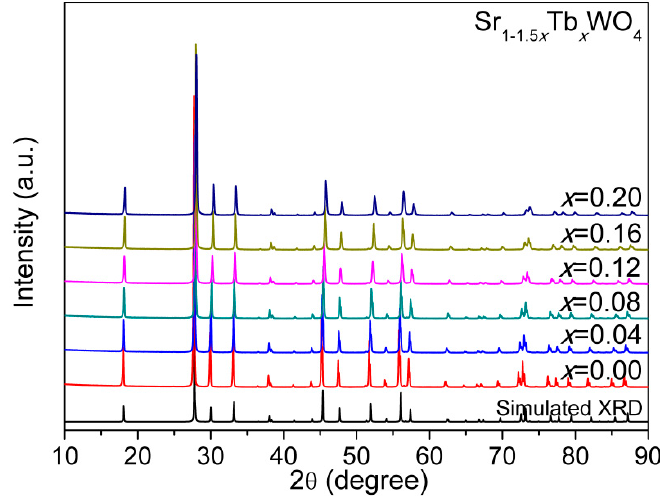
Figure 1. The XRD patterns for the Sr 1 − 1.5x Tb x WO 4 (0 ≤ x ≤ 0.20), where the simulated XRD pattern for undoped SrWO 4 is also given.